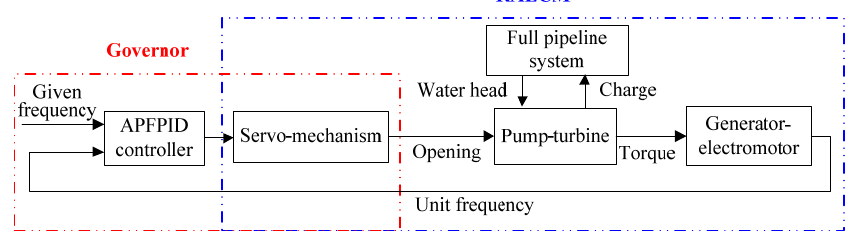
Figure 1. The block-diagram of the PSUGS.